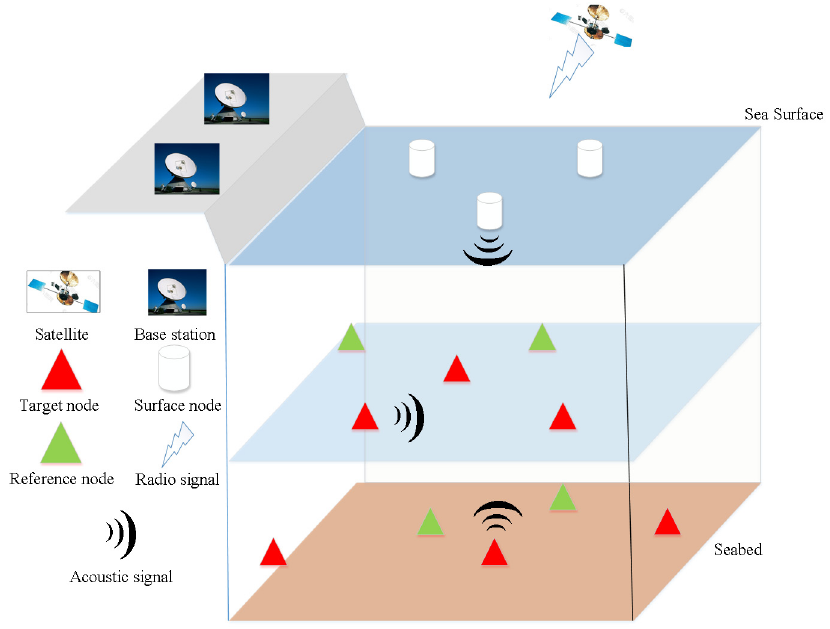
Figure 1. System architecture of underwater wireless sensor networks (UWSNs).